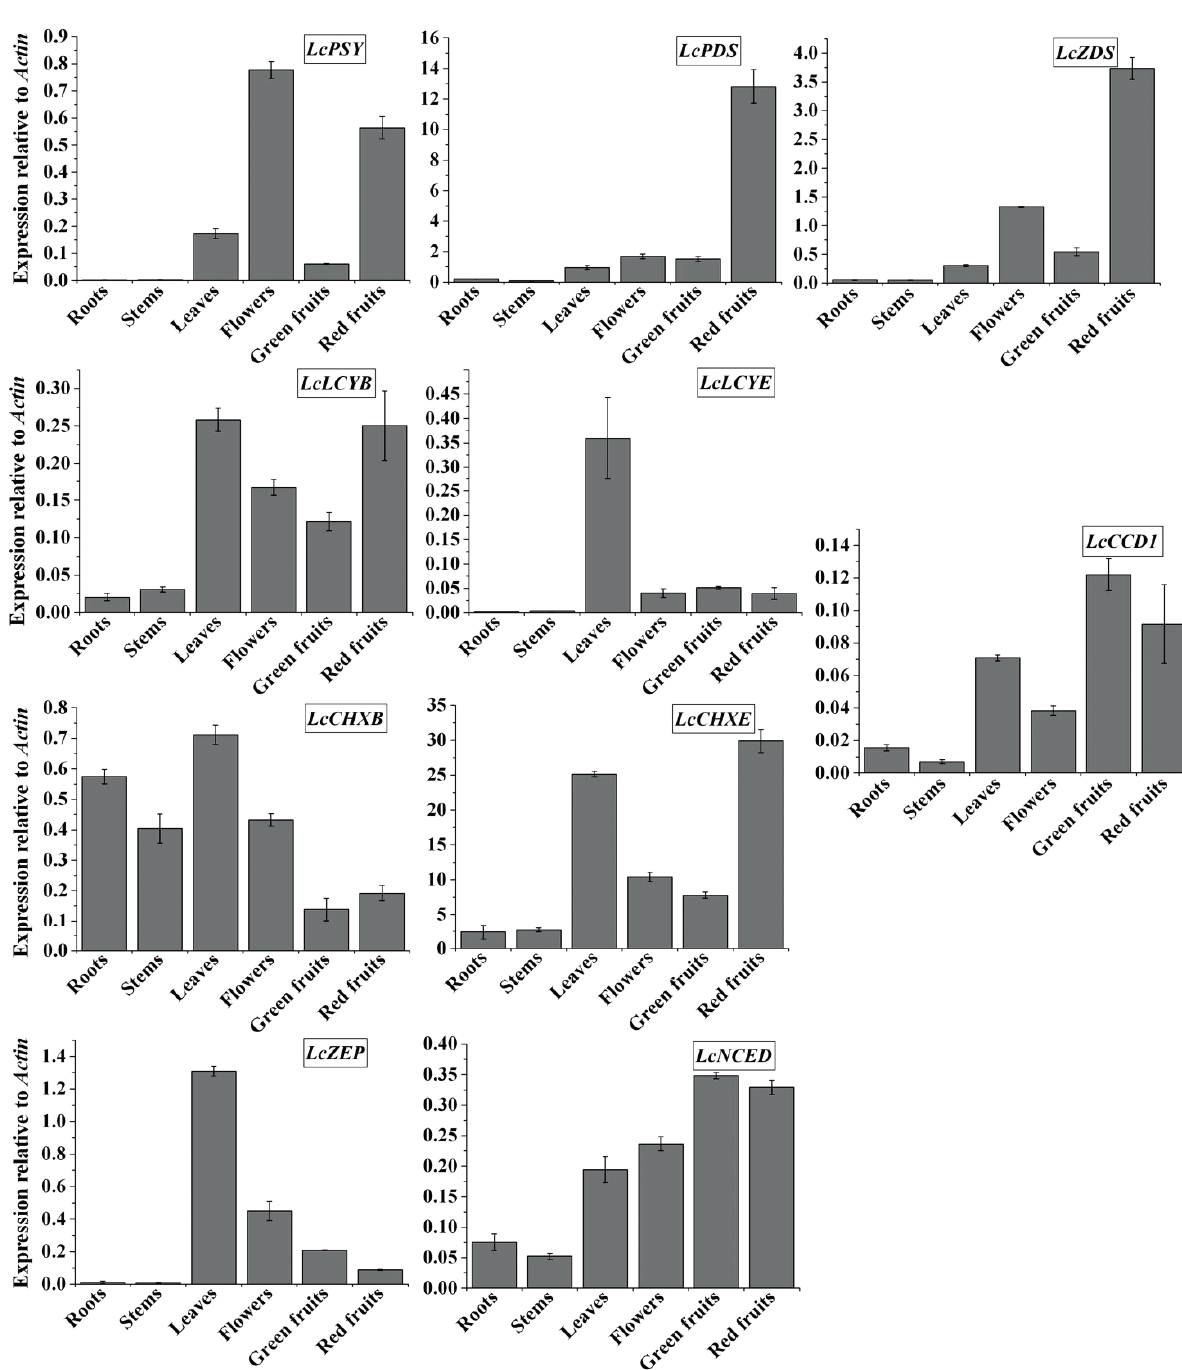
Figure 2. Expression levels of carotenoid biosynthetic genes in different organs of L. chinense. The expression levels of carotenoid biosynthetic genes were calculated by the relative quantification method with the L. chinense actin housekeeping gene. The height of each bar and the error bars indicate the mean and standard error, respectively, from 3 independent